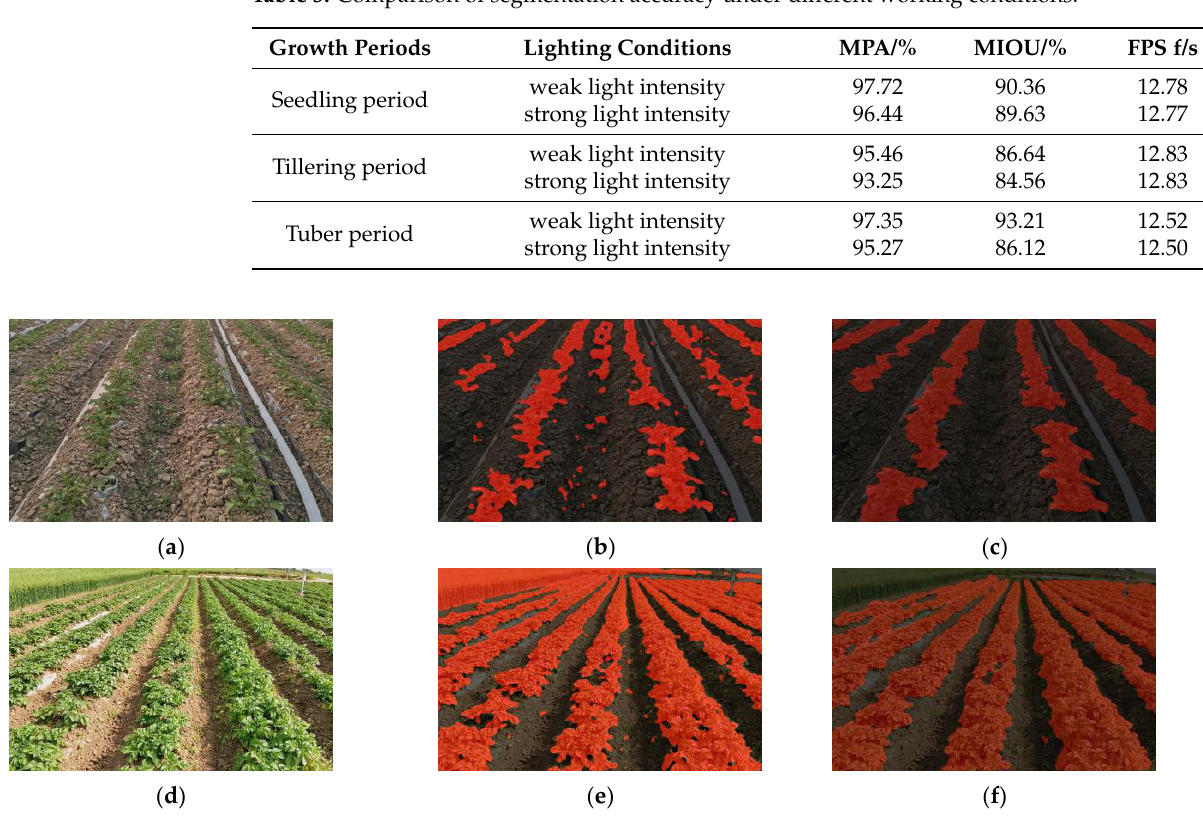
Table 3. Comparison of segmentation accuracy under different working conditions.